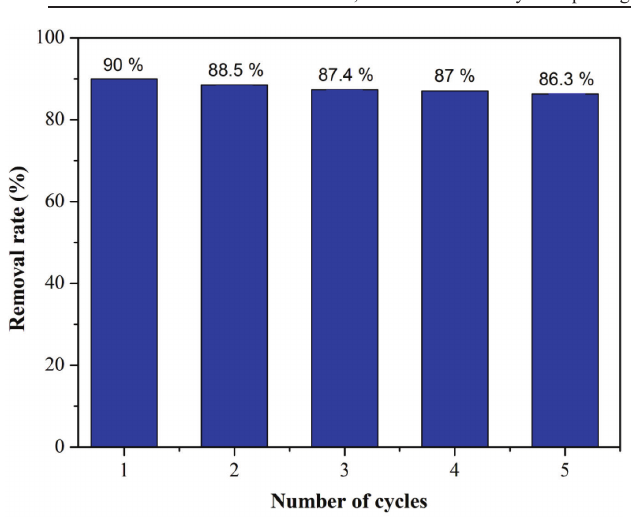
Fig. 11 – Recycling efficiency of CLDH after retention of CA for a CA/CLDH mass ratio of 3